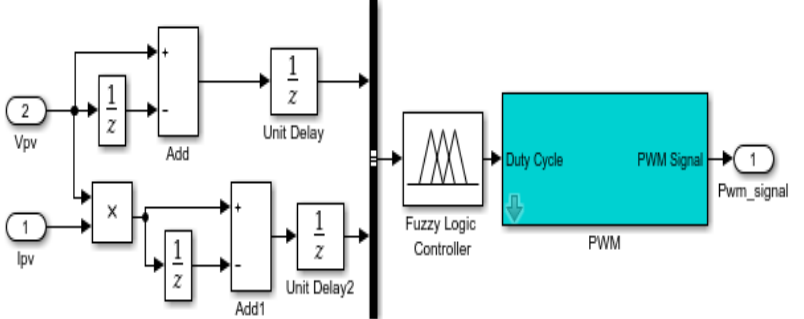
Figure 20. Simulink model of the perturb and observe (P&O)-optimized fuzzy logic strategy (Figure 18, green).